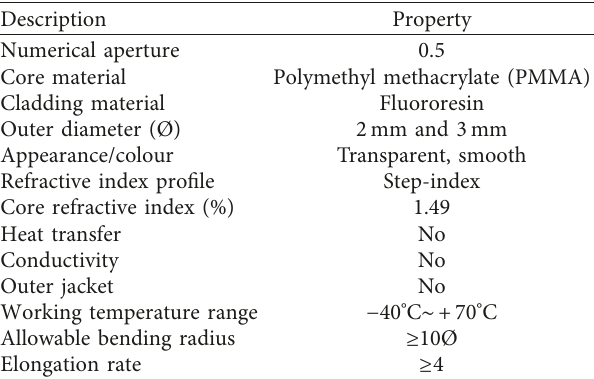
Table 2: Specification of the plastic optical fiber